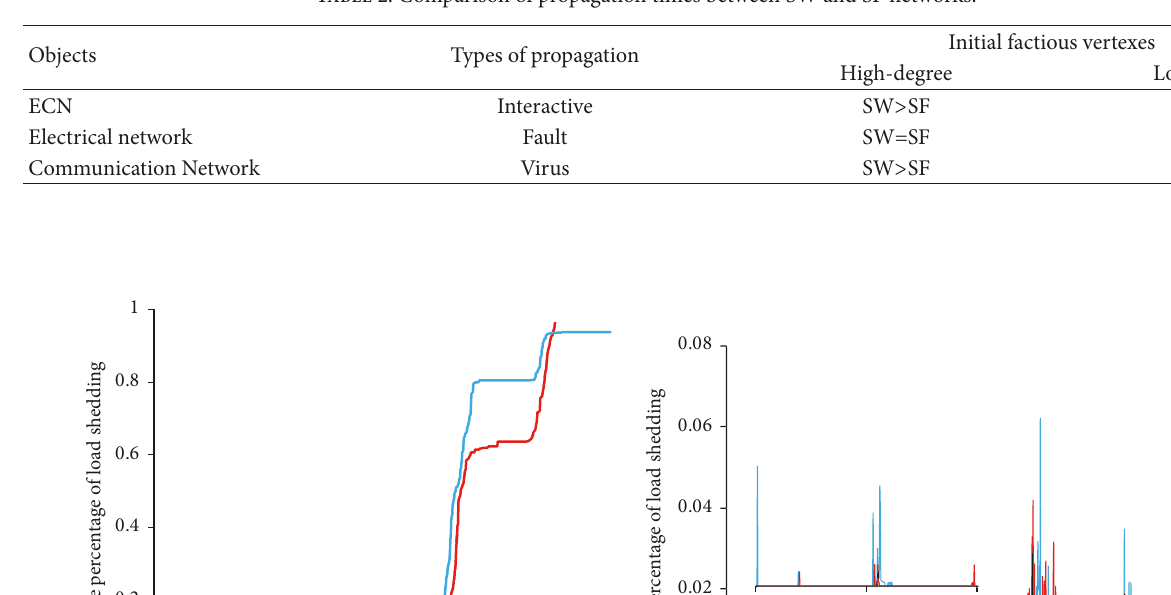
Table 2: Comparison of propagation times between SW and SF networks.